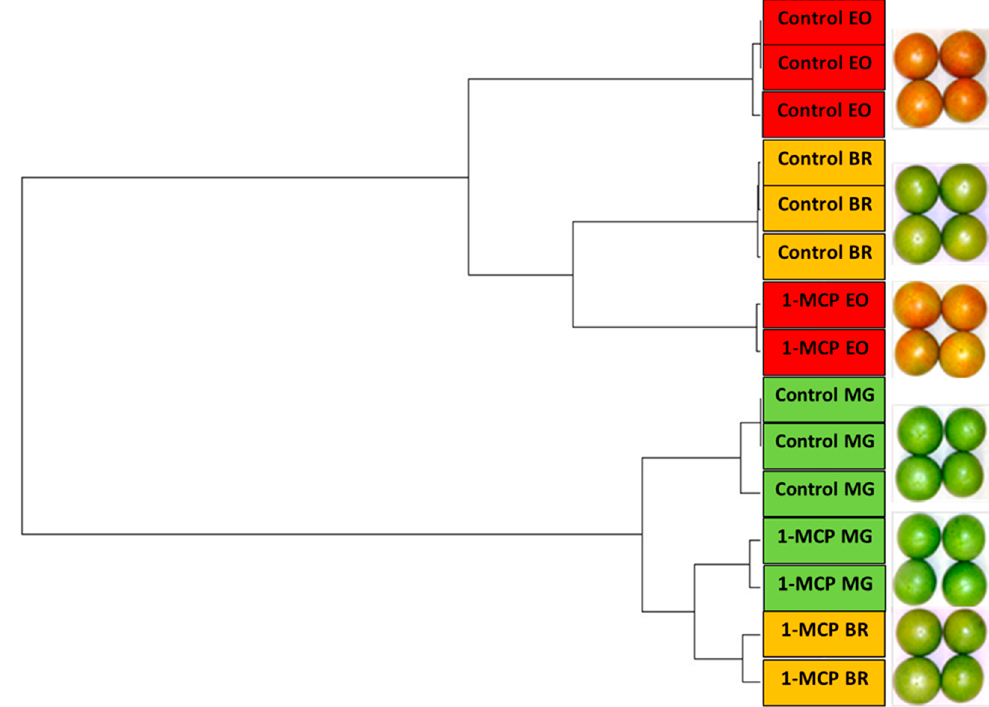
Figure 3. Clustering analysis of samples. The distance in the dendrogram was calculated using pairwise Pearson’s dissimilarities between differentially expressed genes (fold change of ±2, FDR < 0.05). The clustering was performed using the made4 package of R statistical software. For each maturity stage, two replicates of 1-MCP treated and three replicates of untreated tomatoes were used. MG-mature green, BR-breaker, EO-early orange.